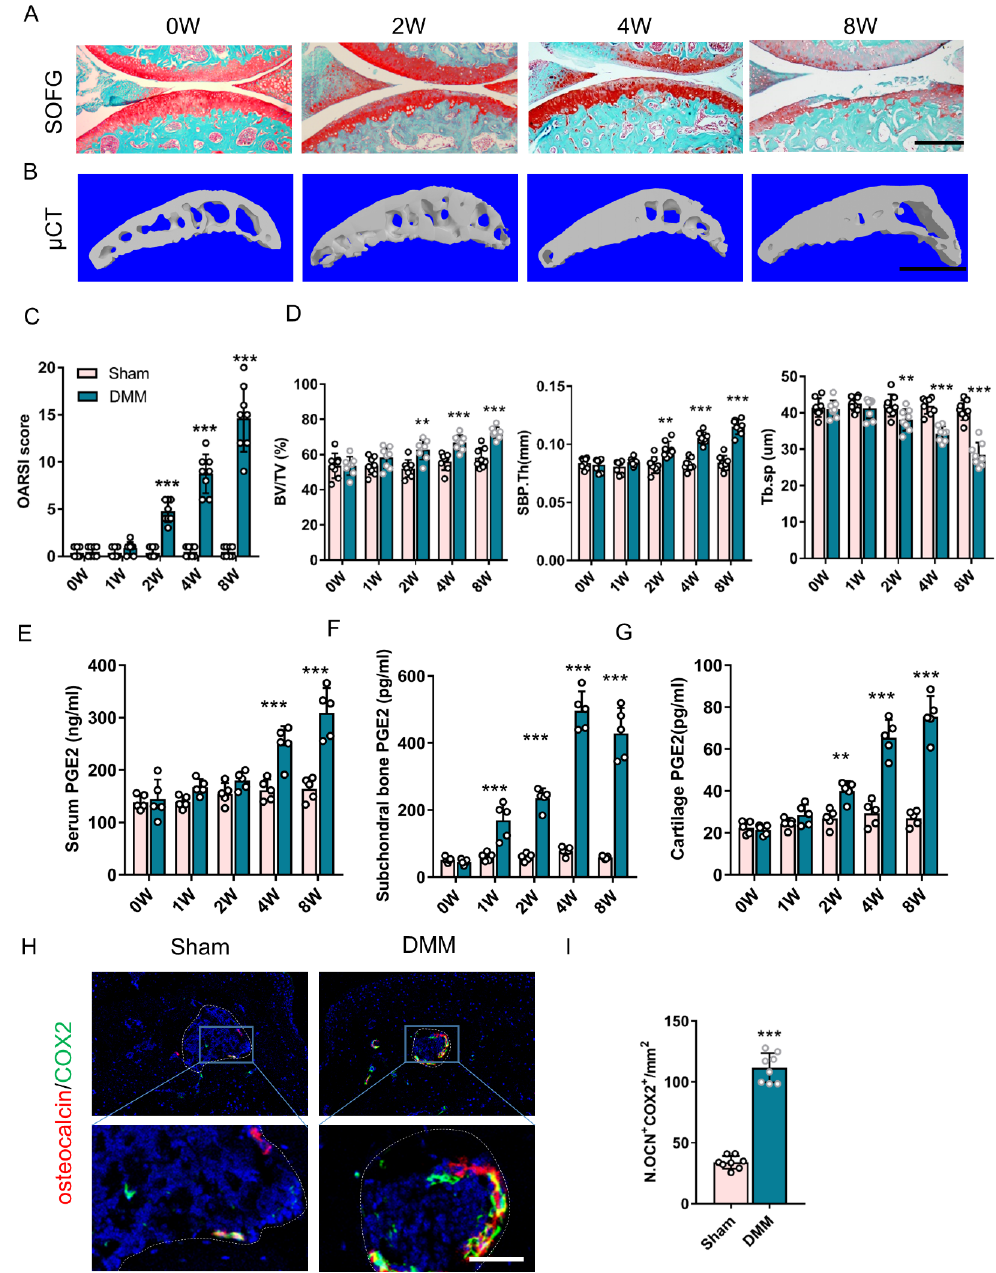
Figure 1. PGE2 level is highly related to joint degeneration in the DMM model. ( A ) Safranin O/Fast green (SOFG) staining of the medial compartment of mouse tibial subchondral bone (sagittal view) at zero, two, four, and eight weeks following DMM surgery. Scale bar: 200 µ m. ( B ) Three-dimensional microcomputed tomography ( µ CT) images of the medial compartment of the tibial subchondral bone (sagittal view). Scale bar: 500 µ m. ( C ) Osteoarthritis Research Society International (OARSI) scores. n = 8 mice per group. ( D ) Quantitative analysis of the structural parameters of subchondral bone: bone fraction (BV/TV), trabecular bone separation (Tb.sp), and subchondral bone plate thickness (SBP.Th). n = 8 mice per group. ( E – G ) ELISA analysis of PGE2 concentrations in the serum ( E ), subchondral bone ( F ), and articular cartilage ( G ) of mice following DMM or sham surgery. n = 5 mice per group. ( H , I ) Representative double immunofluorescent images ( H ) and quantitative analysis ( I ) of osteocalcin (red) and COX-2 (green) in subchondral bone from DMM or sham mice 4 weeks after surgery. Scale bar: 30 µ m. n = 8 mice per group. ** p < 0.01 and *** p < 0.001, means